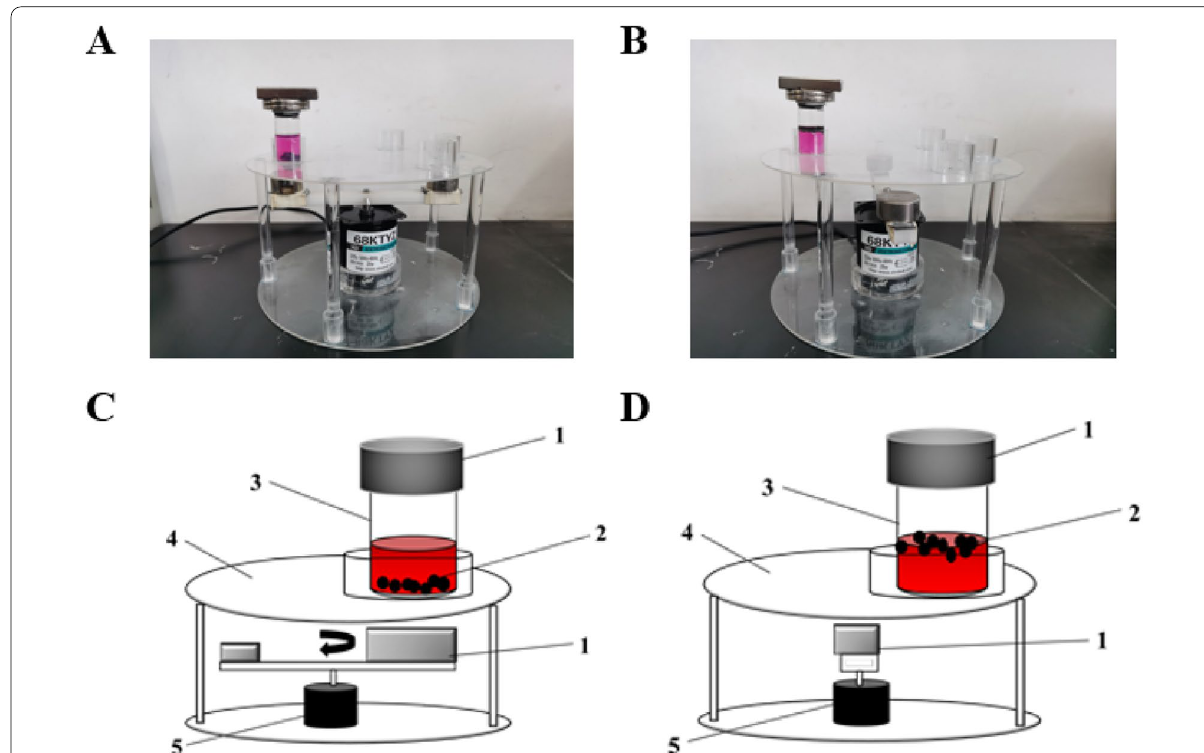
Fig. 2 A , B Reality images of a magnetically controlled bioreactor. C , D Schematic diagram of a magnetically controlled bioreactor. 1, magnet; 2, magnetic hydrogel beads; 3, reaction vessel; 4, bracket; 5, drive